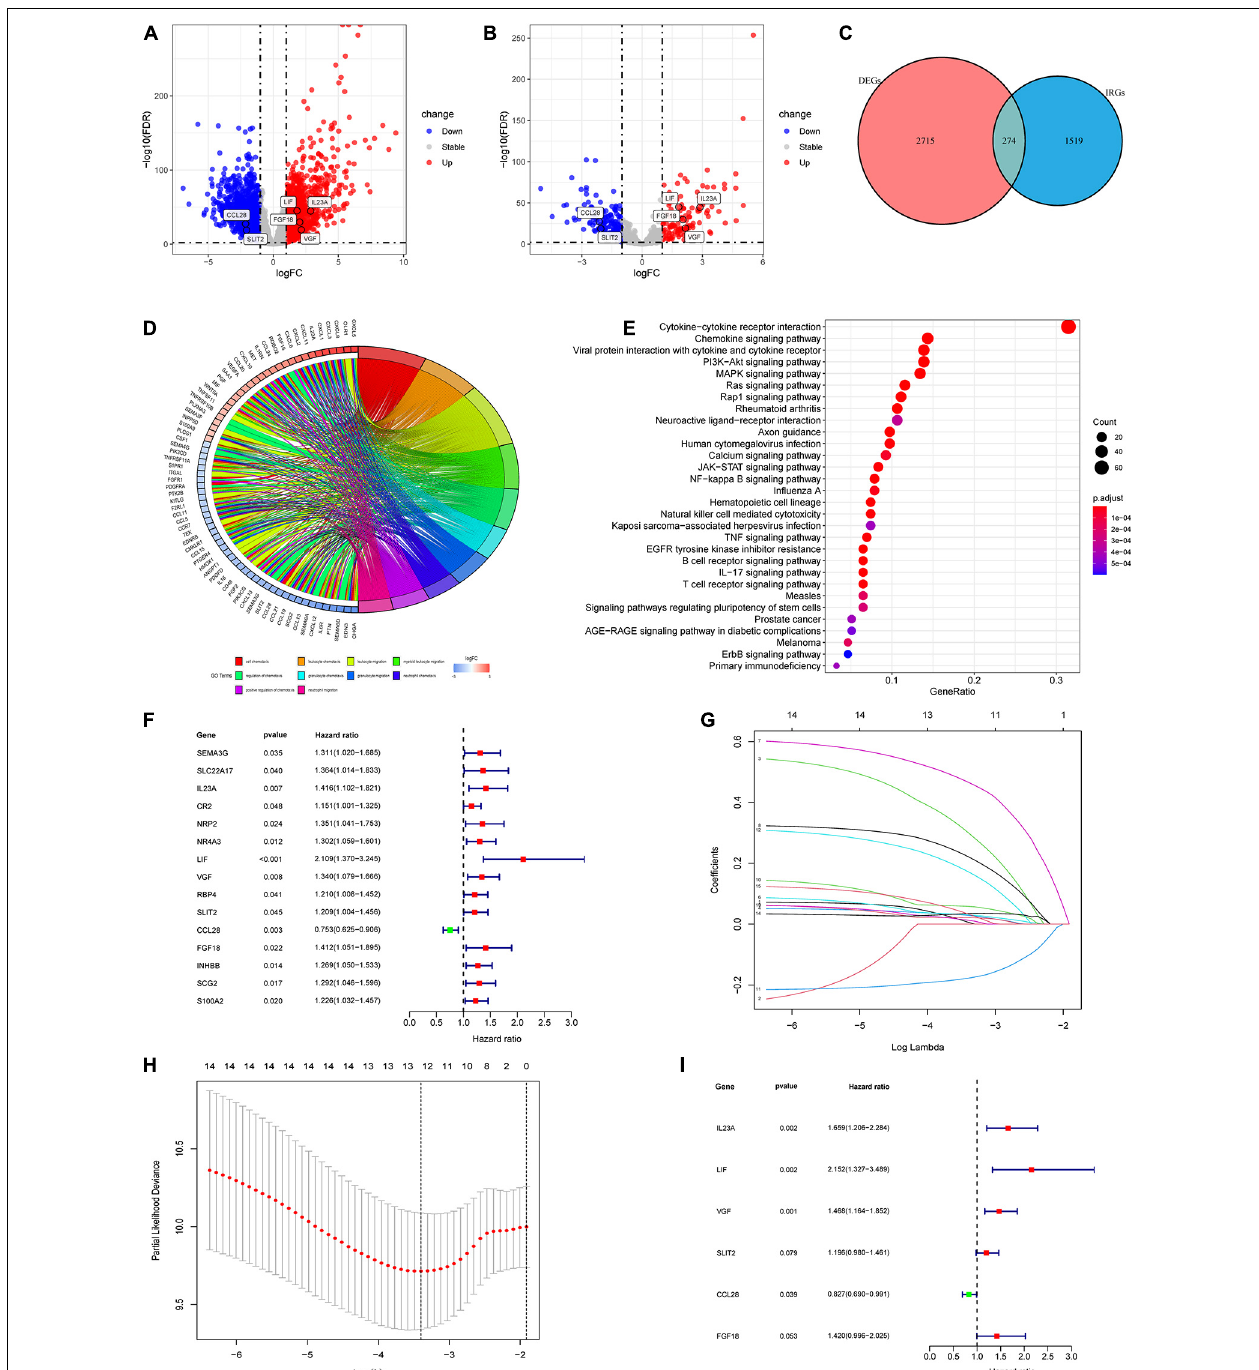
FIGURE 2 | Identification of differentially expressed IRGs and construction of the IRGCRCII model. The volcanic map of DEGs (A) and differentially expressed IRGs (B) between stage II CRC and normal colorectal tissue, where red represents upregulation and blue represents downregulation, p < 0.01, | log 2 FC| > 2. Venn diagram for the intersections between DEGs and IRGs (C) . GO and KEGG pathway enrichment analysis of differentially expressed IRGs (D,E) . A forest map showing the relationship between differentially expressed IRGs and DFS in the training cohort (F) . Tenfold cross-validation for tuning parameter (lambda) selection in the LASSO model based on minimum criteria for DFS (G) . The LASSO coefficient profiles of survival-related IRGs. The dotted line indicates the value chosen by tenfold cross-validation (H) . Forest plot of IRGs based on multivariate Cox regression analysis (I) . p < 0.05. CRC, colorectal cancer; DEGs, differentially expressed genes; DFS, disease-free survival; GO, Gene Ontology; KEGG, Kyoto Encyclopedia of Genes and Genomes; LASSO, the least absolute shrinkage and selection operator method.